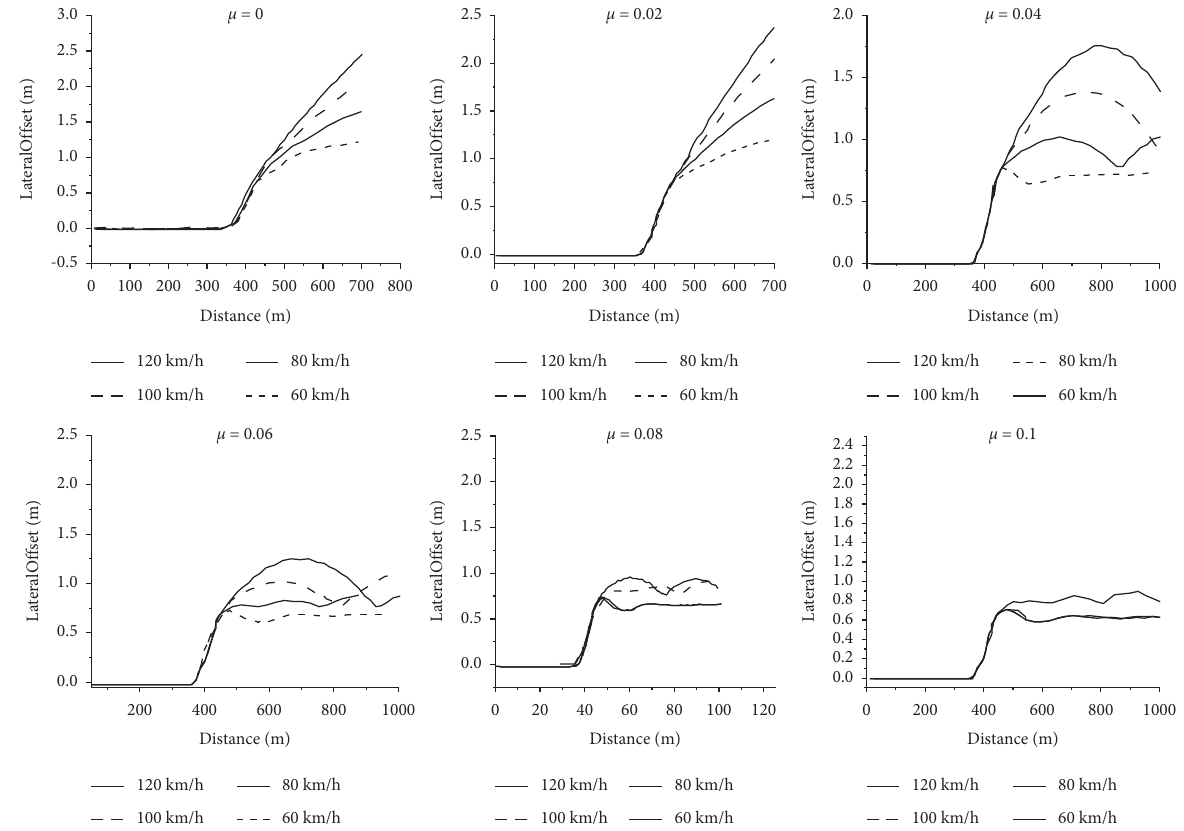
Figure 9: Lateral offset from design path at different friction coefficients and speeds ( L tire and rutting surface). (a) µ � 0, (b) µ � 0.02, (c) µ � 0.04, (d) µ � 0.06, (e) µ � 0.08, and (f) µ �